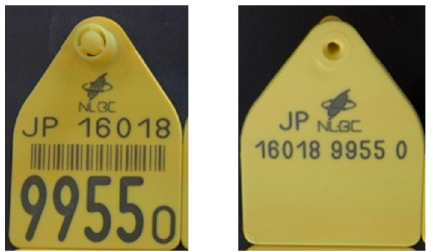
Figure 1. A sample ear tag that is attached to the cow’s ear in Japan.